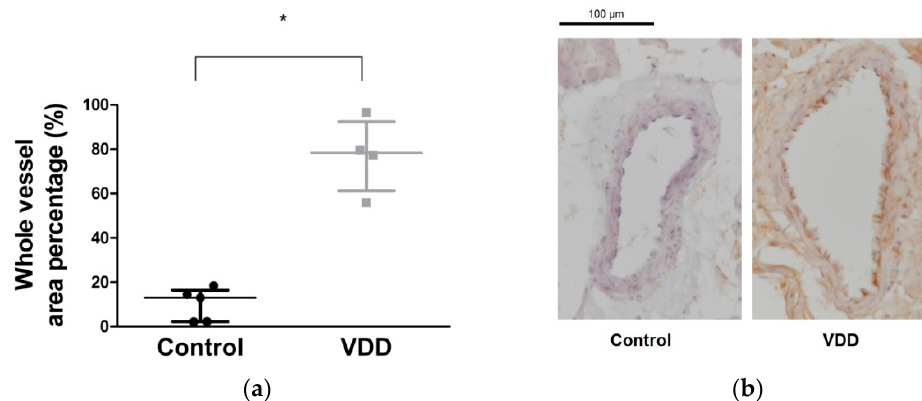
Figure 6. Results of anti-4-hydroxy-2-nonenal (HNE) immunohistochemical staining. ( a ) Percentage area of coronary arteriole cross-sections positively staining with anti-HNE antibodies. Mann–Whitney U-test. Median [IQR], n = 5–4. *: p < 0.05; ( b ) representative photos of HNE immunohistochemistry sections of male rat coronary arteriole segments. Scale bar, 100 µ m.